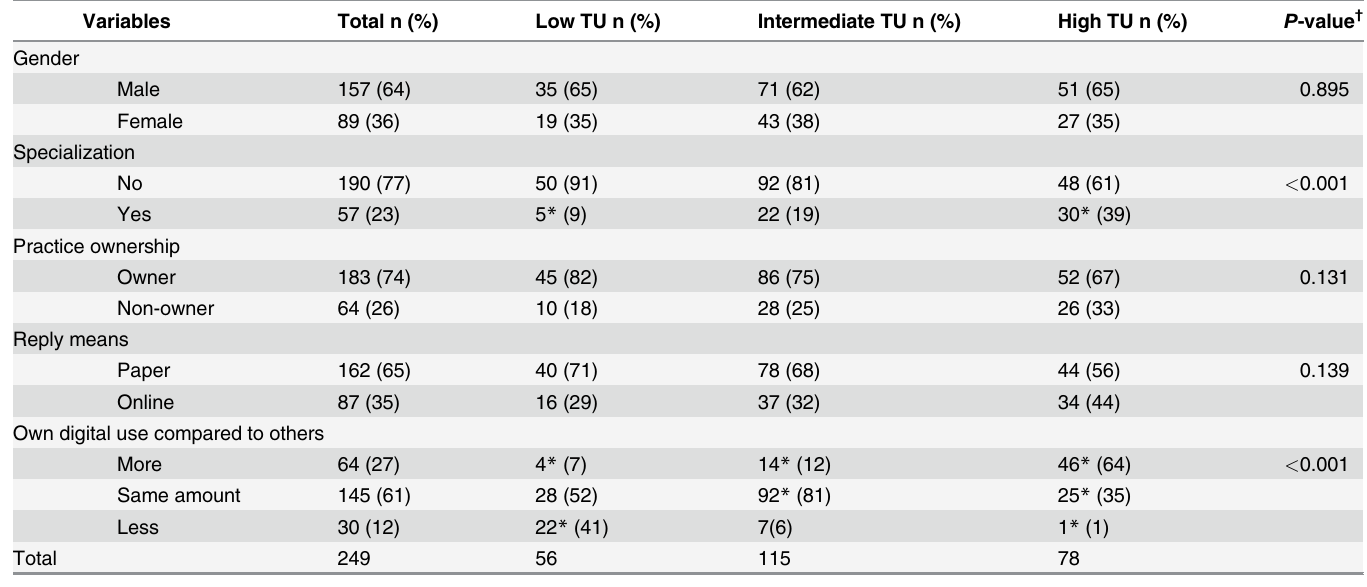
Table 2. Digital technology use by personal characteristics and practice